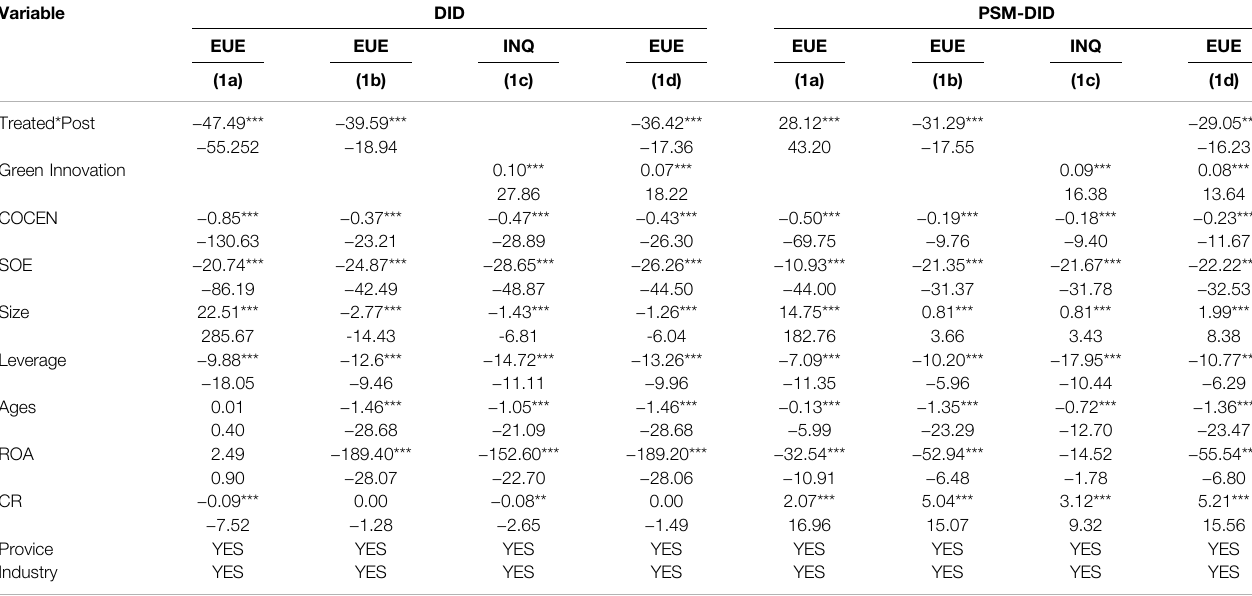
TABLE 7 | Environmental excitation induced effect regression results. Variable